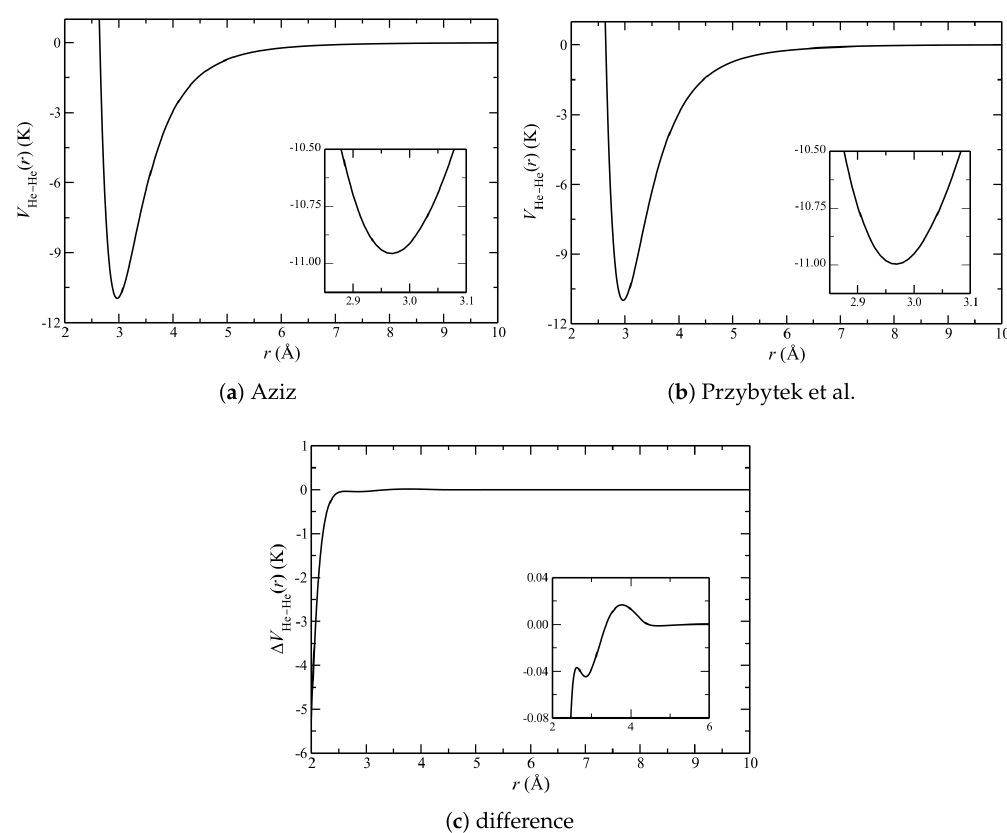
Figure 4. The He–He potential as a function of pairwise separation r . The insets in ( a , b ) show expanded views of the minima; and ( c ) shows the difference between potentials, ∆ V He–He ( r ) = V (b) ( r ) − V (a) ( r ) , with the inset showing an expanded view of the region near and just above the minima.